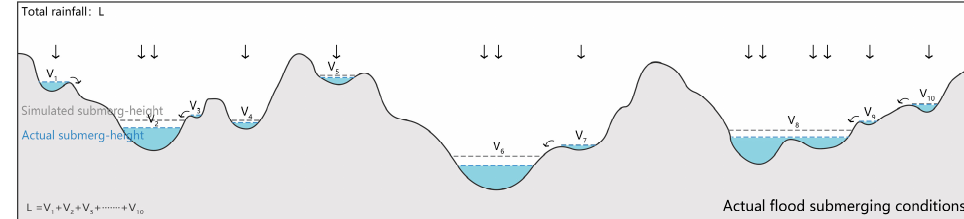
Figure 3. Spatial data fusion.